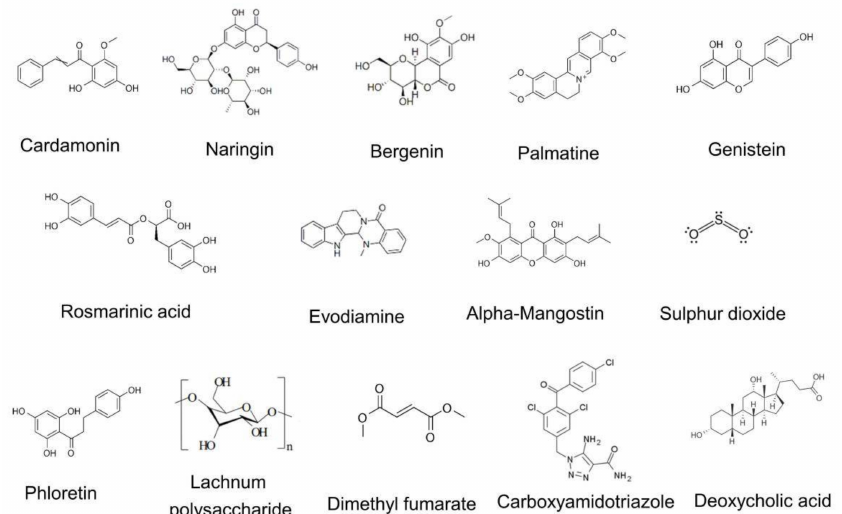
Figure 2. The molecular structure of the chemical compounds that inhibits the activation of the NLRP3 inflammasome. The molecular structures of compounds are diverse; thus these compounds might employ multiple mechanisms in preventing the activation of the NLRP3